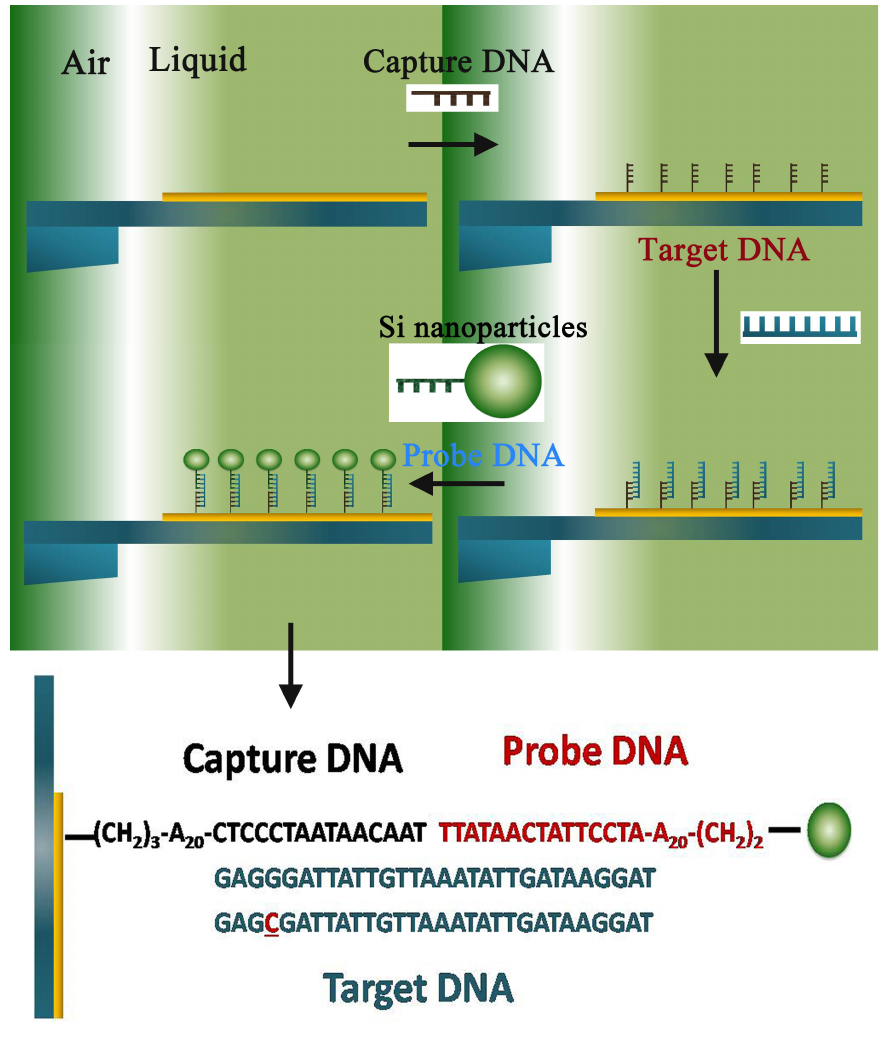
Figure 3. Proposed scheme of hybrid the spin-microcantilever based on in situ DNA detection using a nanoparticle probe in liquid and the sequences of capture DNA, target DNA, probe DNA and single base pair mismatched